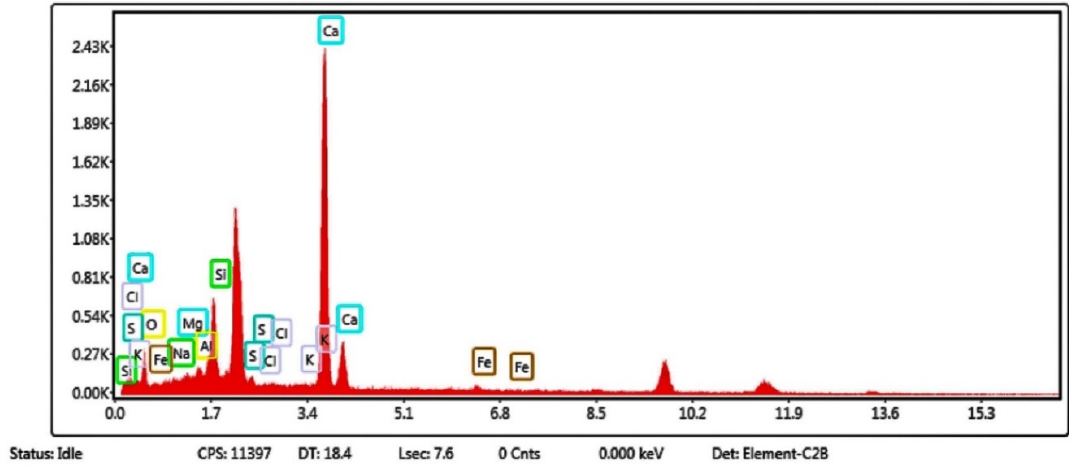
Figure 13. EDS, concrete specimen containing type I bacteria. Table 6. The weight percentage of elements in concrete containing type I bacteria.